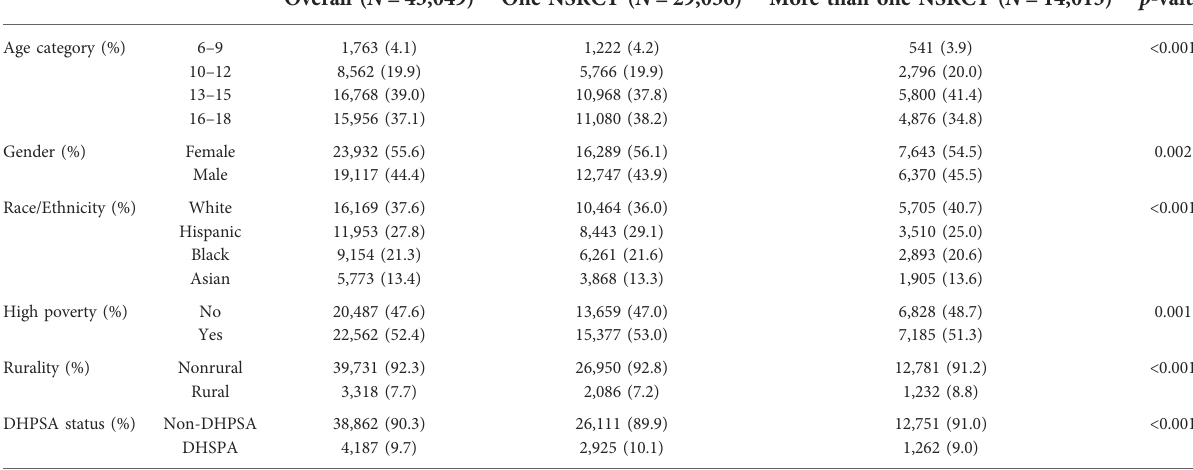
TABLE 1 Characteristics of study population strati fi ed by initial root canal therapy (NSRCT)